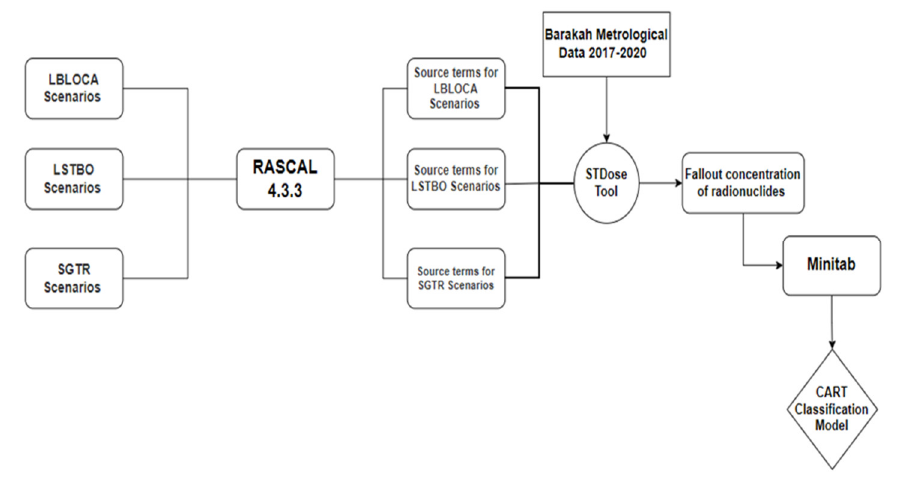
Figure 1. Schematic approach for methodology and analysis .